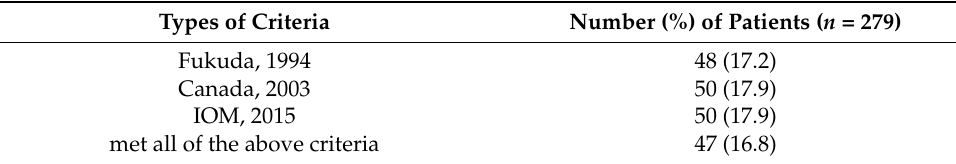
Table 1. Numbers and proportions of patients who met the ME/CFS criteria. Types of